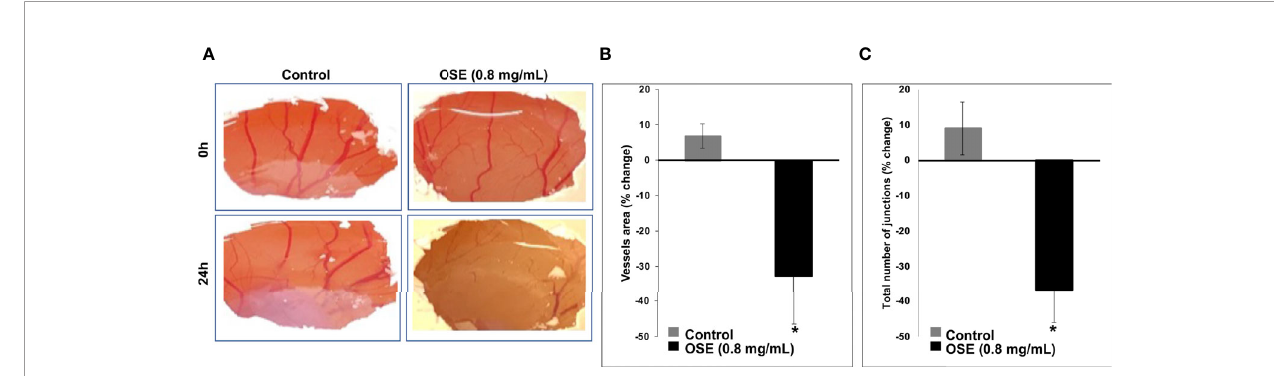
FIGURE 7 | OSE inhibits angiogenesis in ovo . OSE (0.8 mg/ml) was added on the CAM of E6 embryo. Photographs (A) taken 24h after treatment show the change in vessels area (B) and the total number of junctions (C) . Values are represented as mean ± SEM (*p <